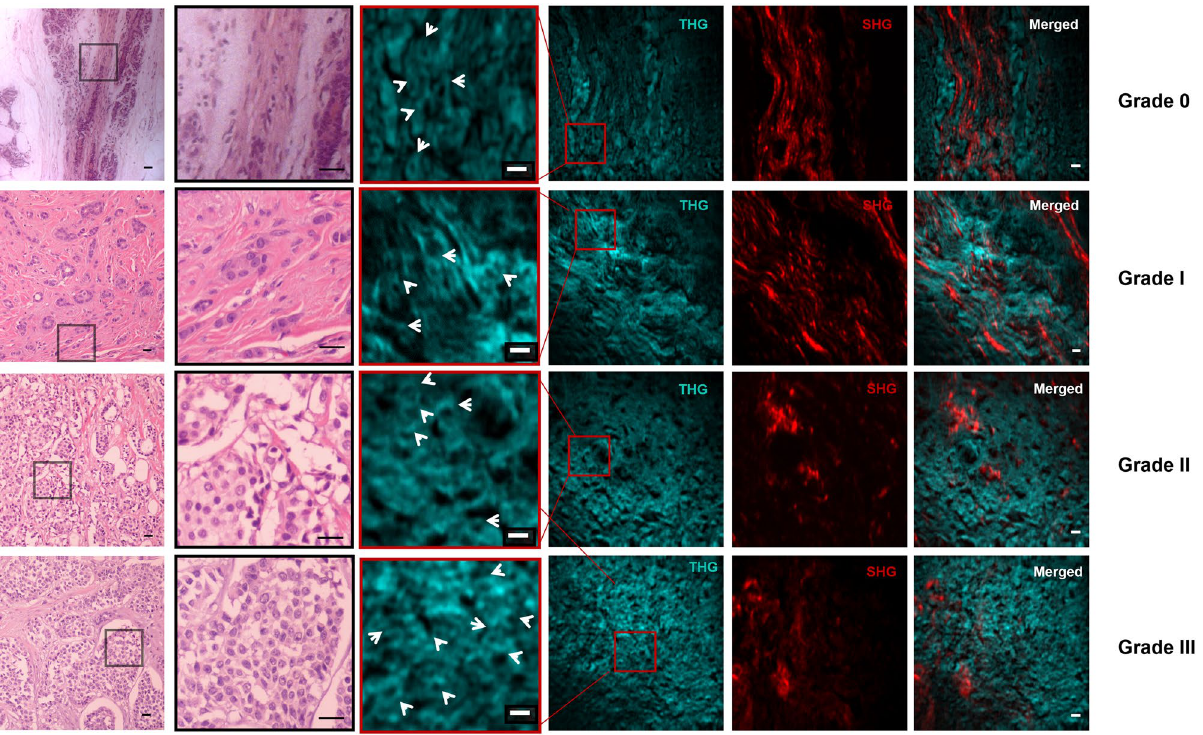
Figure 2. Hematoxylin and eosin (H&E) images and the corresponding non-linear images (SHG & THG) of benign (grade 0) and malignant (grade I, grade II, grade III) breast tissues. Characteristic THG images (cyan) of tissues show intracellular inhomogeneities, while SHG images (red) indicate collagen (scanning area ~ 150 μm 2 ). Black squares in the H&E images indicate the regions that were scanned during the non-linear imaging measurements. The second column presents the zoomed H&E images. Red squares in the THG images represent the area that is enlarged in the third column (scanning area ~ 45 × 45μm 2 ) to identify the cells. White arrows indicate typical cancer cells in the tissues. Scale bar depicts 5 μm for non-linear images and 10 μm for H&E images.